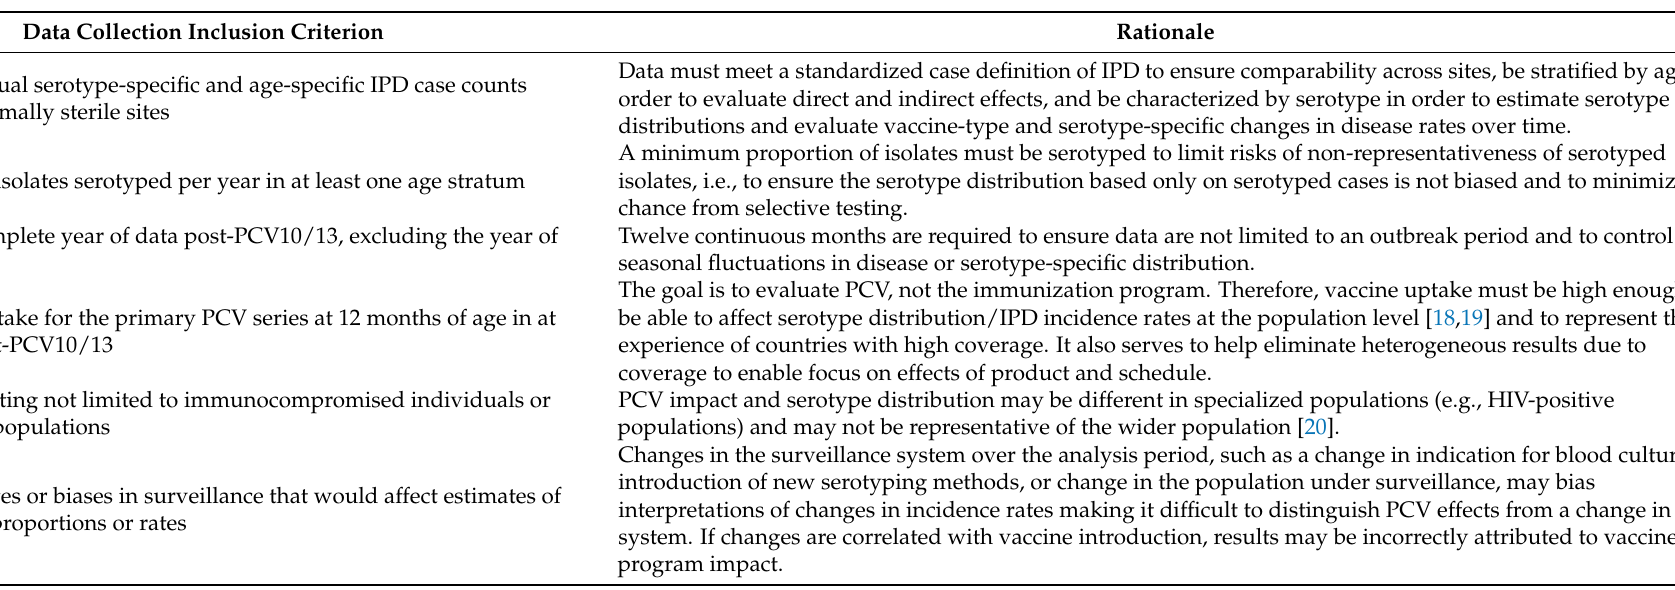
Table 1. Data collection inclusion